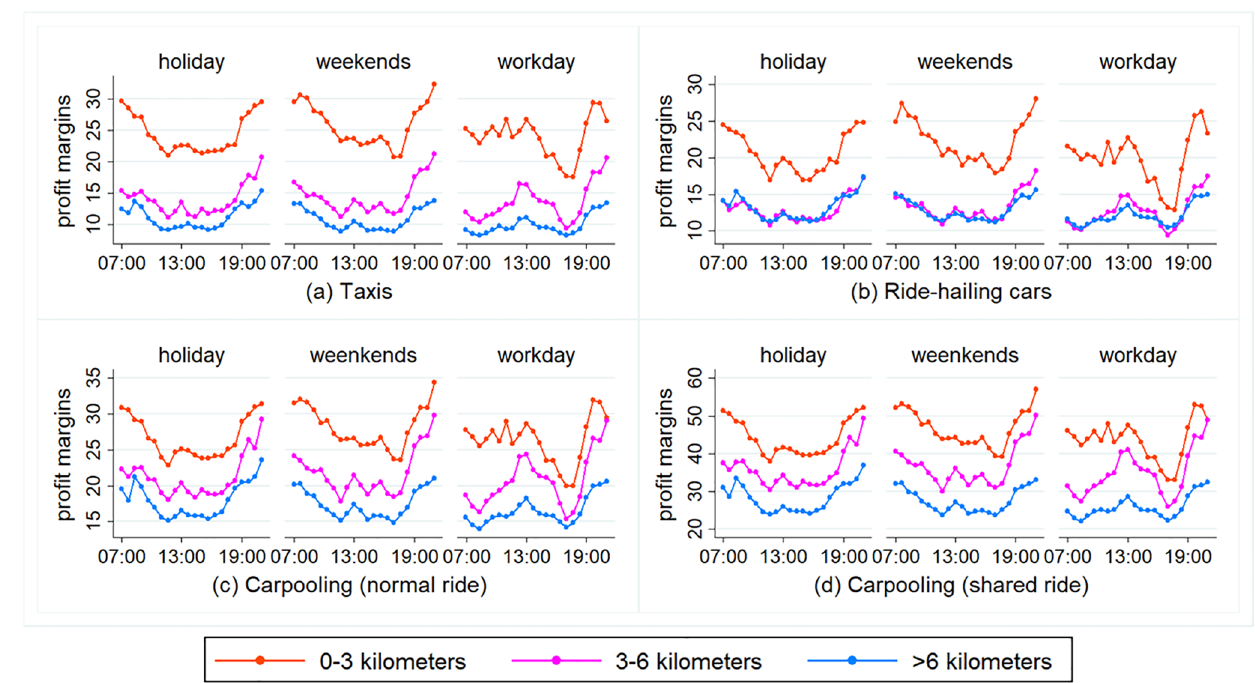
Fig 2. Comparing profit margins of taxis (online ride-hailing cars) on different trip